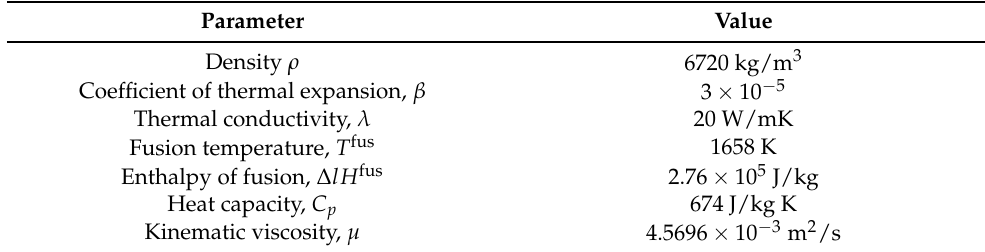
Figure 10. Configuration of the thin metallic layer test case. Left: illustration of the global IVR context coupling the corium pool (oxidic layer), the vessel and the thin metallic layer. Right: actual geometry considered in the present simulations (BALI experiment [30]) focusing on the coupling between the thin metallic layer and the vessel. Table 2. Physical properties of steel—Values taken from